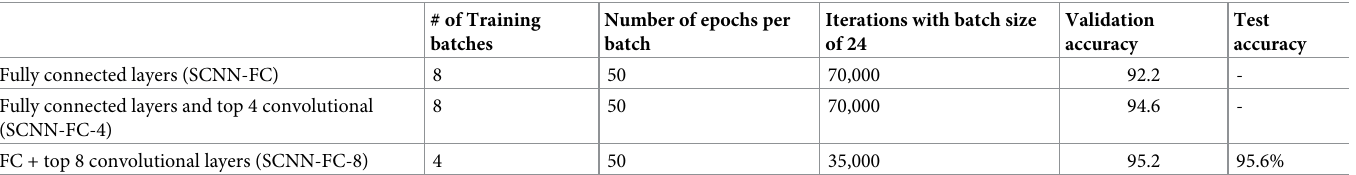
Table 1. Results of model after